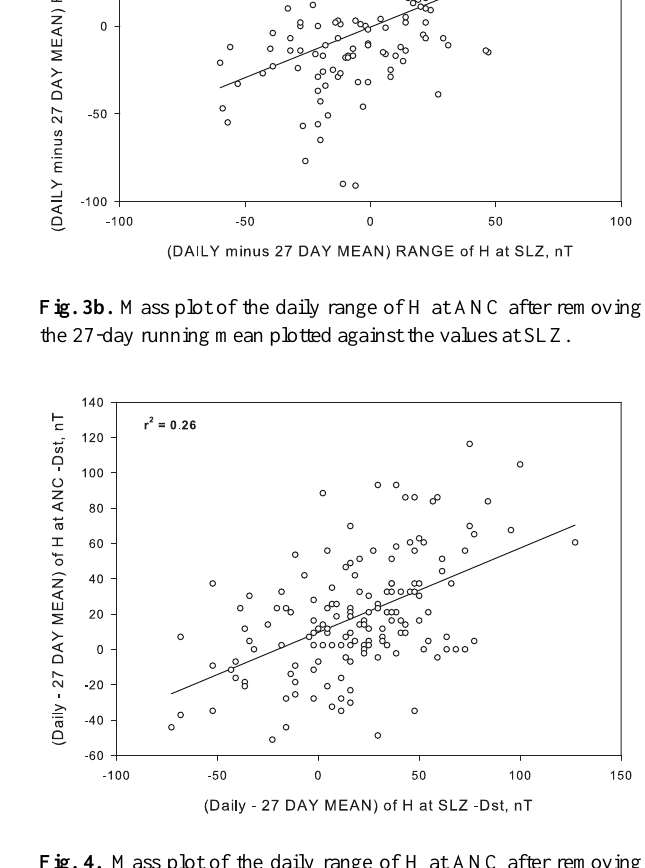
Fig. 4. Mass plot of the daily range of H at ANC after removing both the 27-day running mean and D st plotted against similar values at